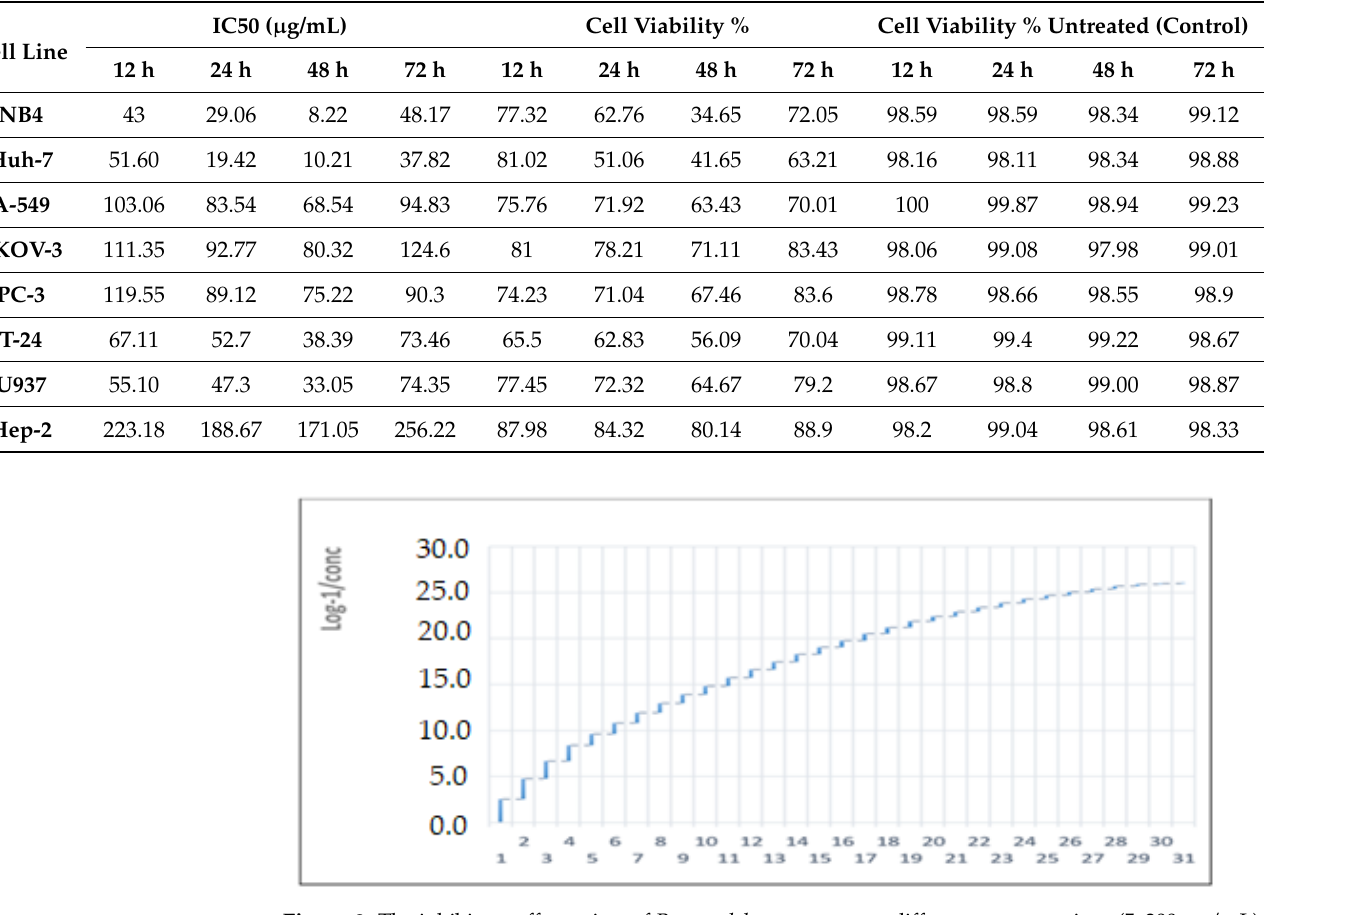
Table 3. Anti-cancer impacts of P. amygdalus var . amara alcoholic seed extractions.